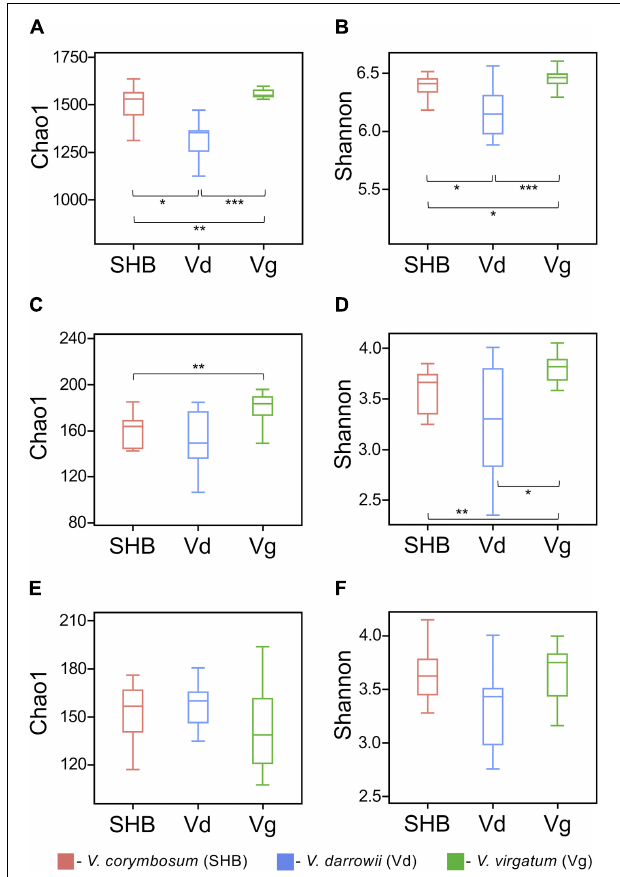
FIGURE 2 | Alpha diversity (Chao1 and Shannon indices) of bacteria (A,B) , fungi (C,D) , and non-fugal eukaryotes (E,F) in the rhizosphere of studied blueberry species. Significant differences between V. corymbosum , V. darrowii , and V. virgatum are indicated in each figure panel (* P < 0.05, ** P < 0.01, *** P <